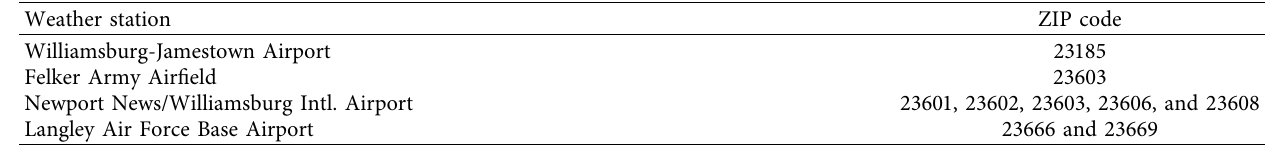
Figure 4: The spatiotemporal traffic speed matrix, where blue is the congested areas. Table 1: The TMC ZIP codes and the corresponding weather